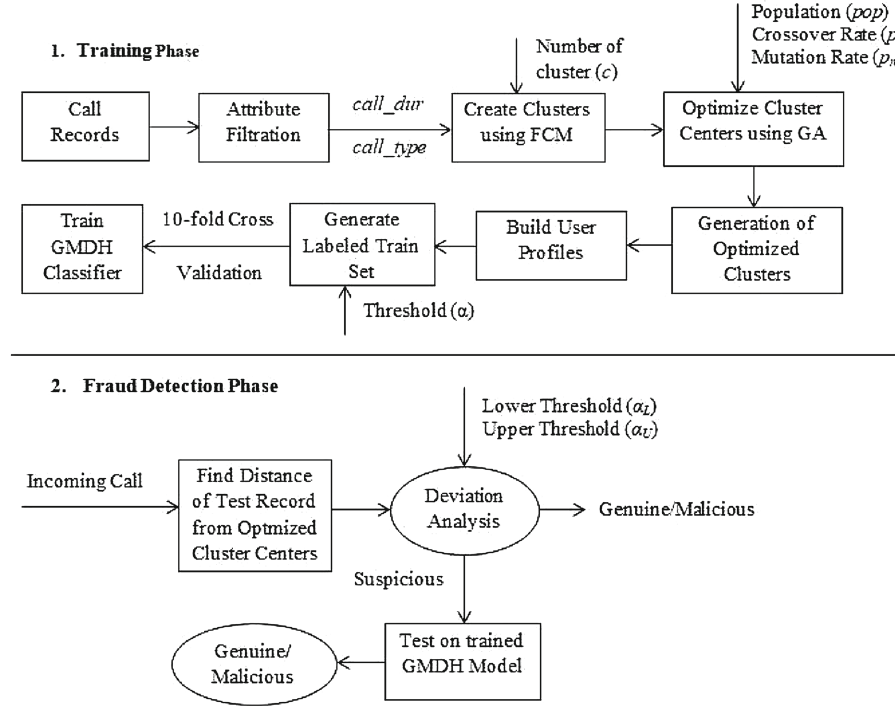
Fig. 2 Workflow of the proposed